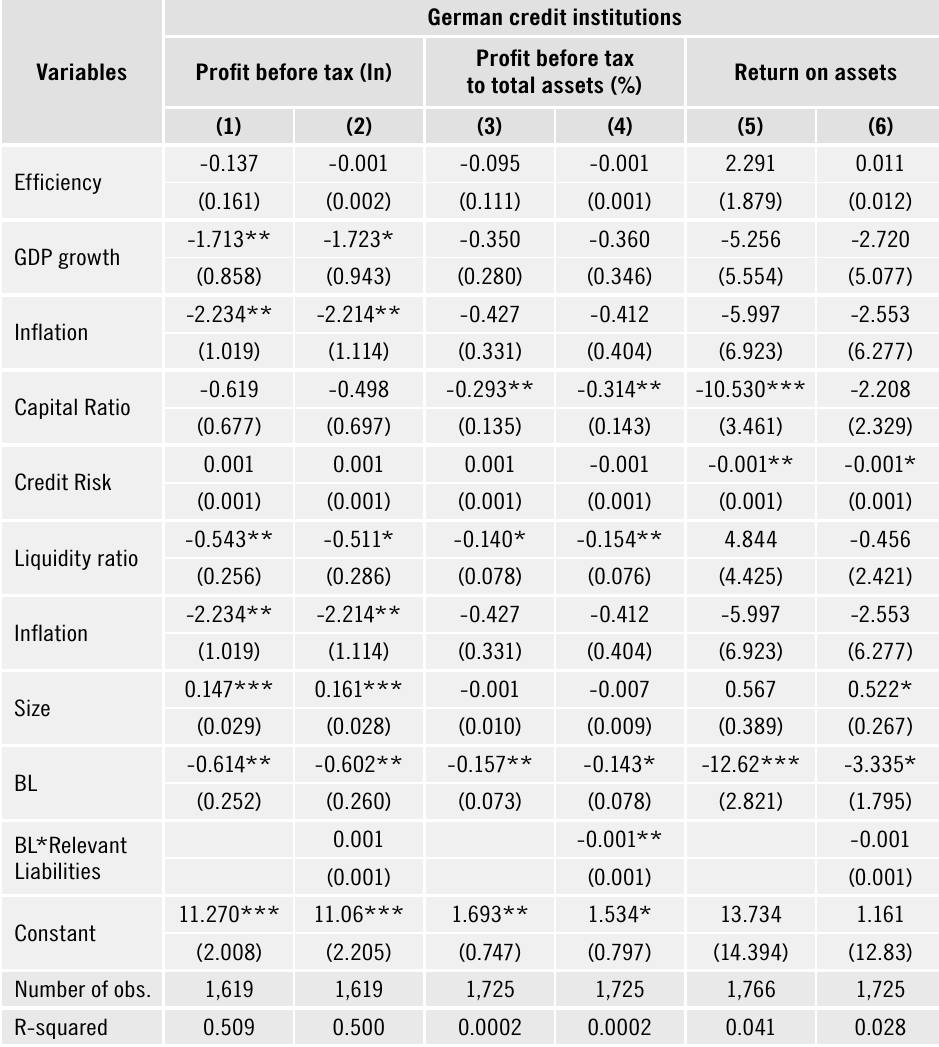
Table 5. Data presenting estimates based on GLS regressions with a random effect on German credit institutions in 2005–2015. Data have been sourced from unconsolidated financial statements. Institution-specific characteristics appear as one-year lagged variables in all specifications. The bank levy (BL) is represented by a dummy variable indicating 1 for all years the levy applies to, and zero for all remaining years. Robust standard errors that control for clustering at the financial institution level are reported in